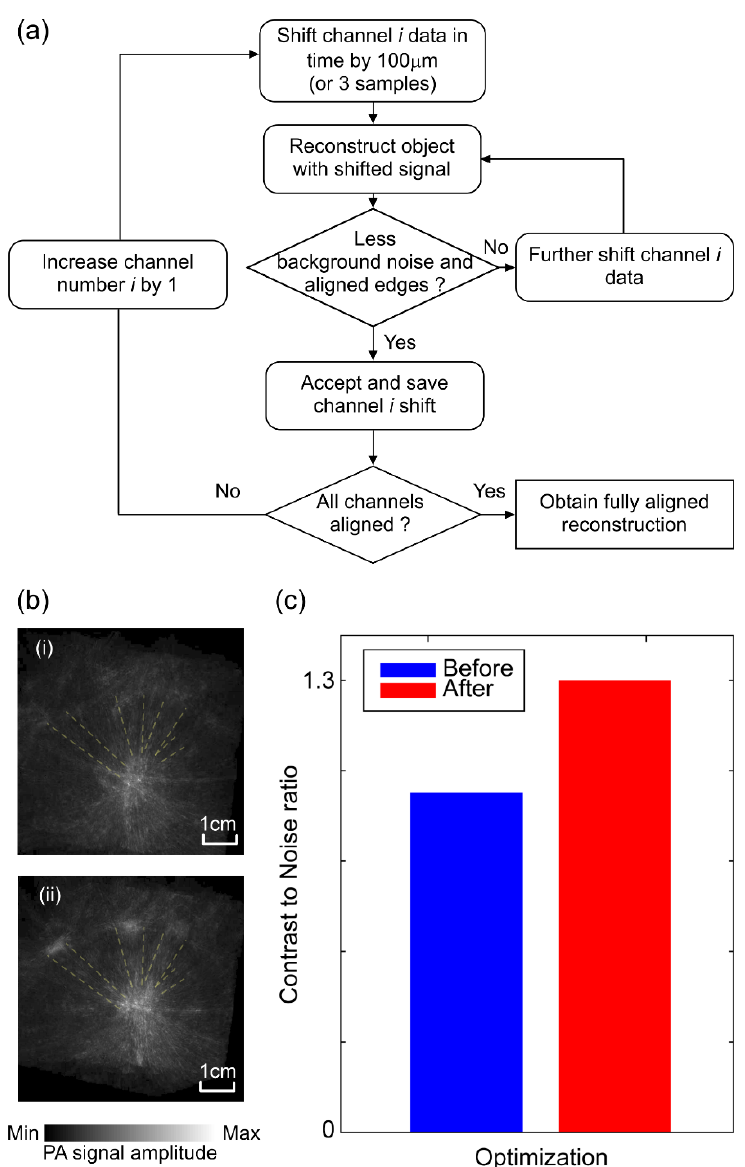
Figure 3. ( a ) Flowchart of the continuous sequential optimization algorithm; ( b ) reconstructed images of four leg phantom (i) before and (ii) after optimization; ( c ) bar chart demonstrating increase in the contrast to noise ratio of the reconstructed images before and after optimization.